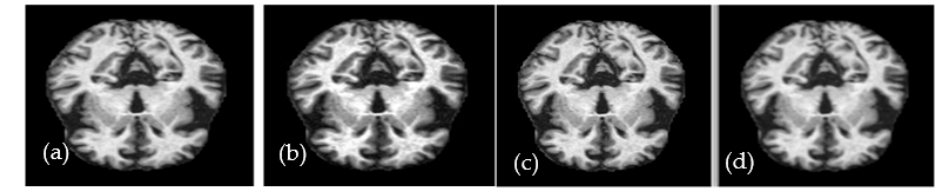
8 of 30 Figure 1. ( a ) Distribution of 4 different classes and ( b ) a sample image in the selected dataset. 3.2. Preprocessing and Data Augmentation Preprocessing: Images might have noise and distortions in their datasets. Radiog- raphy noise is typically brought on by changes in the detector’s sensitivity, decreased con- trast due to poor illumination of the object, photographic restrictions, and spontaneous variations in the radiation signal. To enhance the data’s quality or optimize their geomet- ric and intensity patterns, preprocessing is essential. Preprocessing draws attention to the most crucial information required for classification and enables researchers to concentrate on a specific section of the brain. The difference between the greatest and lowest pixel intensities, as defined by Equation (1), is contrast enhancement. It enhances image quality and raises border contrast in the image, which makes it easier to distinguish between different organs. By extending the range of pixel values, it also enhances the image’s brightness. 𝑔𝑟𝑎𝑦(𝑥, 𝑦) = 𝐼(𝑥, 𝑦) − 𝑓𝑚𝑖𝑛 𝑓𝑚𝑎𝑥 − 𝑓𝑚𝑖𝑛 × 𝑔𝑟𝑎𝑦_𝑙𝑒𝑣𝑒𝑙𝑠 (1) where I (x, y) represents the value of each pixel in the image, the 𝑓𝑚𝑖𝑛 parameter repre- sents its minimum value, the 𝑓𝑚𝑎𝑥 parameter represents the highest value, and 𝑔𝑟𝑎𝑦(𝑥, 𝑦) represents the enhanced pixel because of applying image contrast. A high- contrast example of an axial MRI brain image is shown in Figure 2. The median filter is a method for reducing noise without introducing edge blur. It is highly suitable for improv-